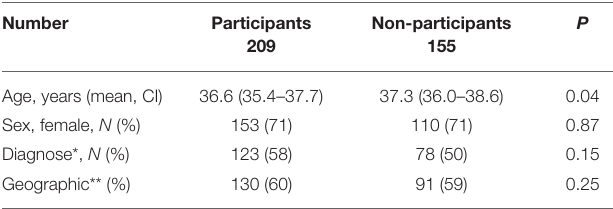
TABLE 2 | Characteristics of participants vs. non-participants, confidence interval (CI).